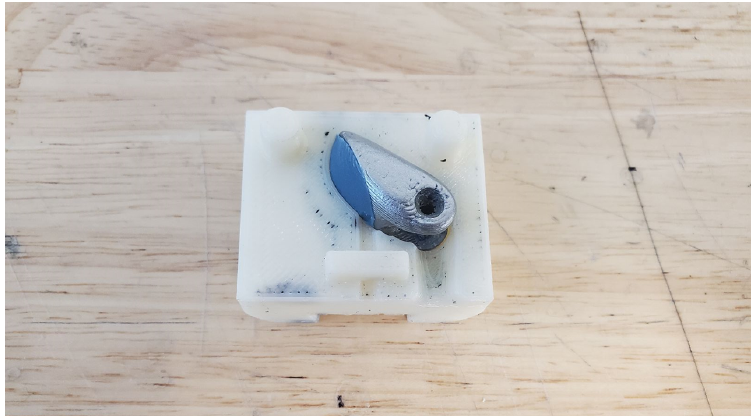
Figure 5. Overmolding achieved on additive manufactured component moulded using a silicon elastomer in a chamber produced by additive